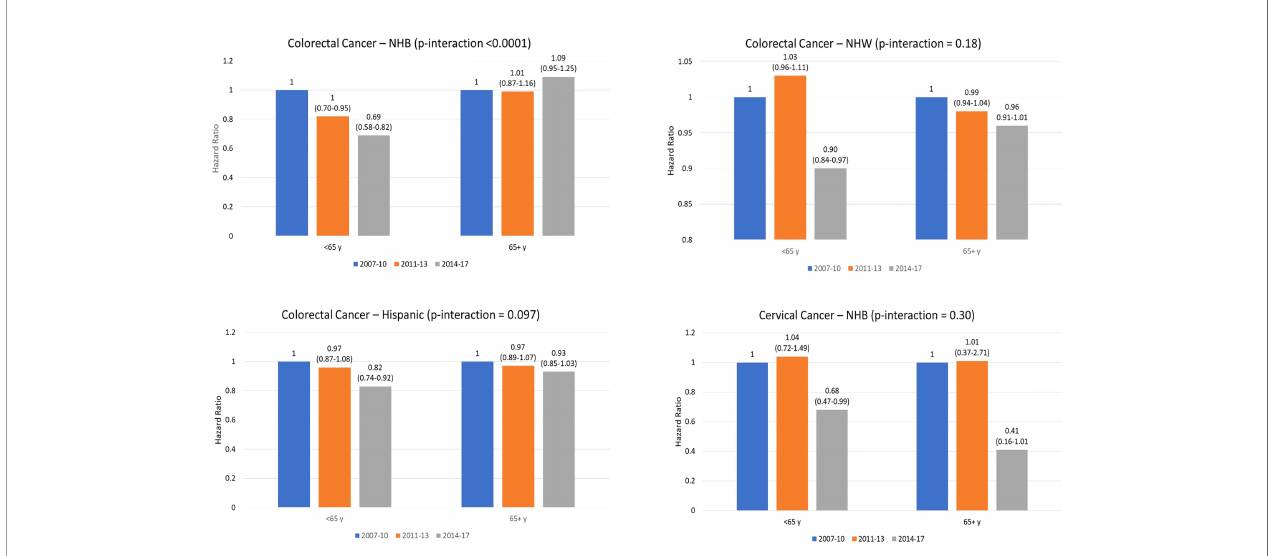
FIGURE 1 | Hazard Ratio (95% coinfedence interval) for cancer-speci fi c death by time period for younger (<65 years) and older (65 years and older) patienets. P- value indicates interaction for difference in mortality between 2014-2017 compared to 2007-2010 between older and younger patients. Note. NHB, non-Hispanic Black; NHW. Non-Hispanic